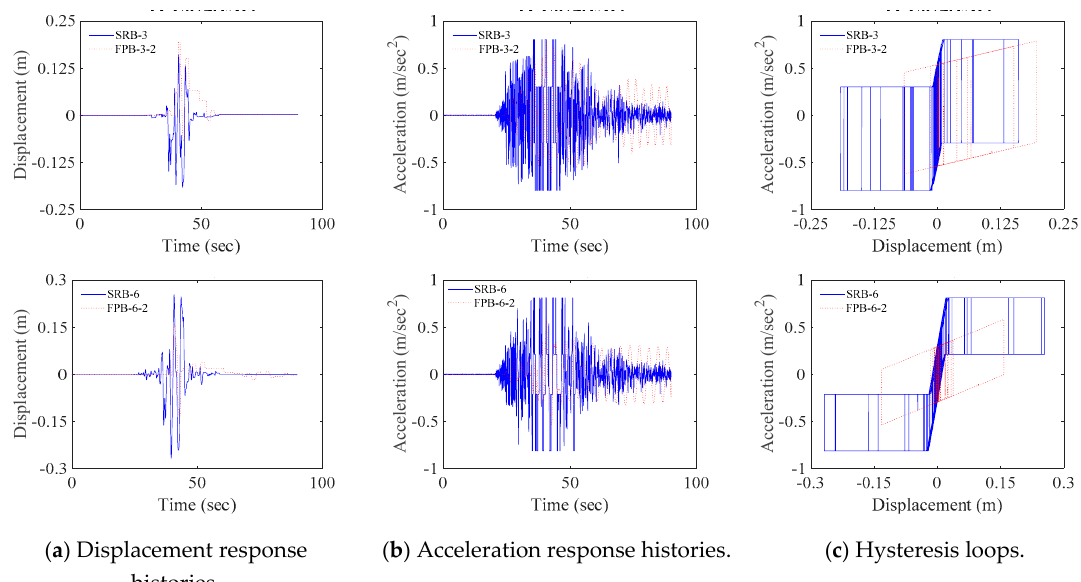
Figure 15. Numerical results of SRB-3, FPB-3-2, SRB-6, and FPB-6-2 under 1999 Taiwan Chi-Chi, TCU074 (EW) (Group 2).